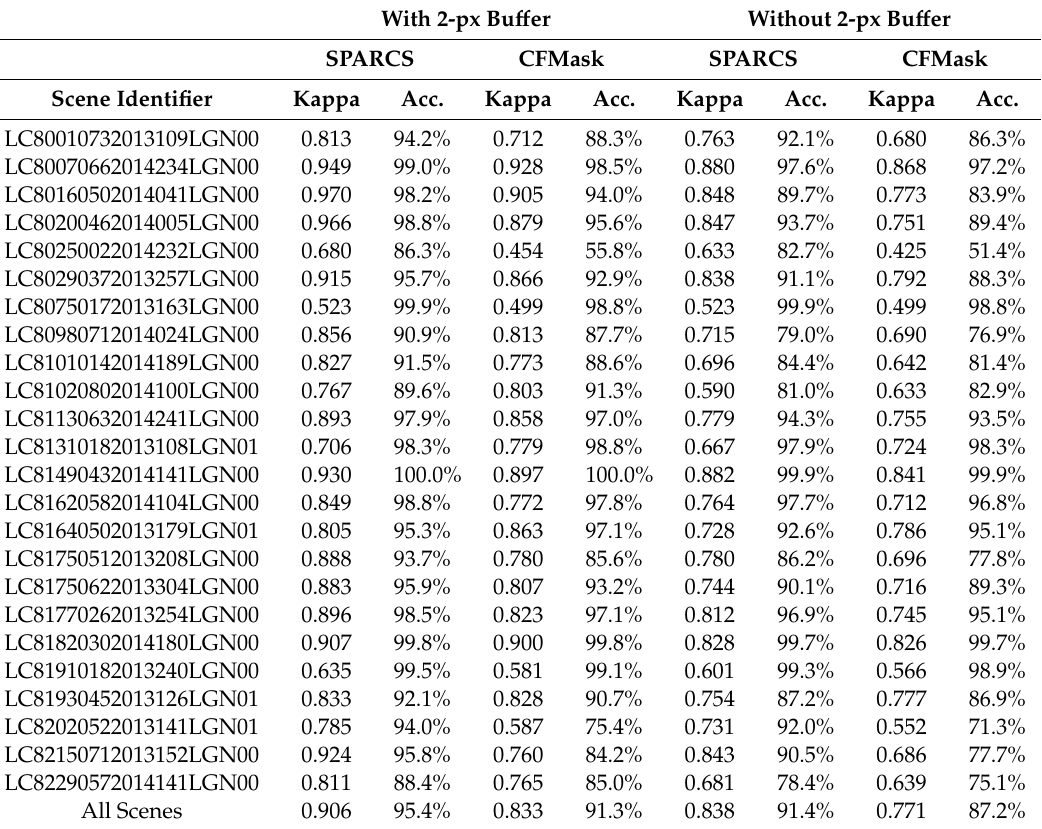
Table A1. Kappa scores and overall accuracy (Acc) for SPARCS and the CFMask over 24 Landsat 8 images from the Landsat 8 Biome Cloud Cover Assessment Validation Dataset